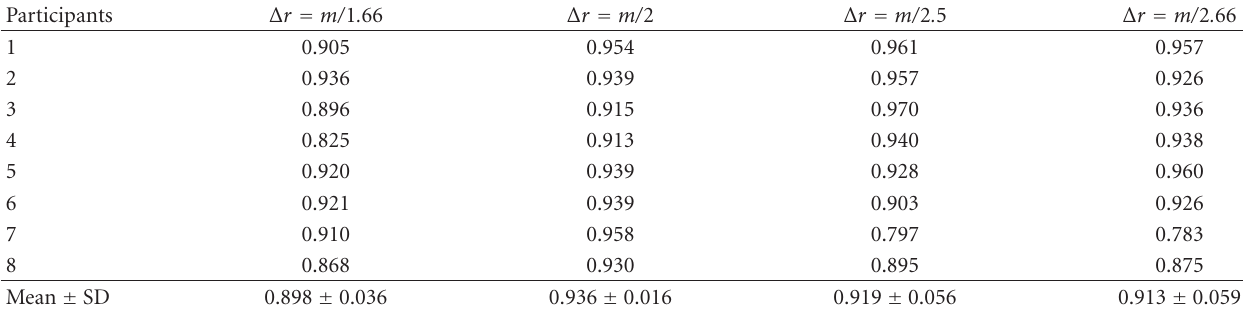
Table 2: Nash and Sutcli ff e’s criterion ( F value) for each participant and for the group using di ff erent Δ r ( m is the mean distance).